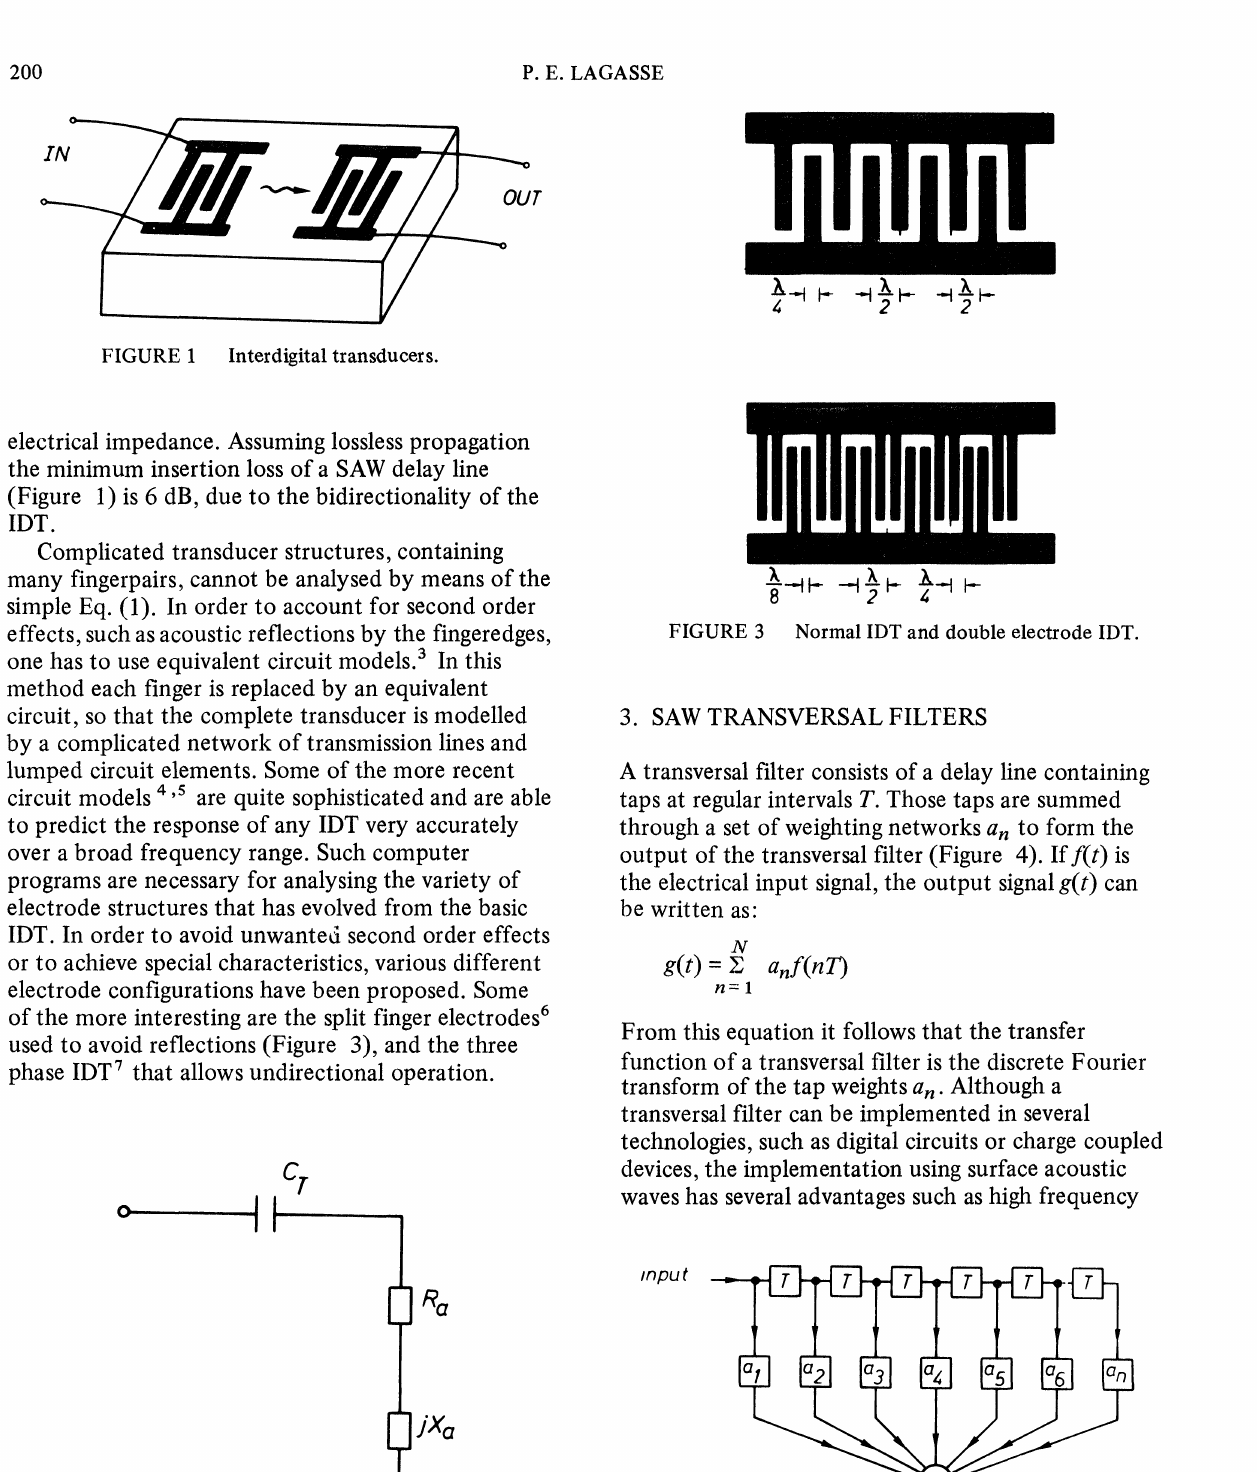
FIGURE 2 Equivalent circuit.